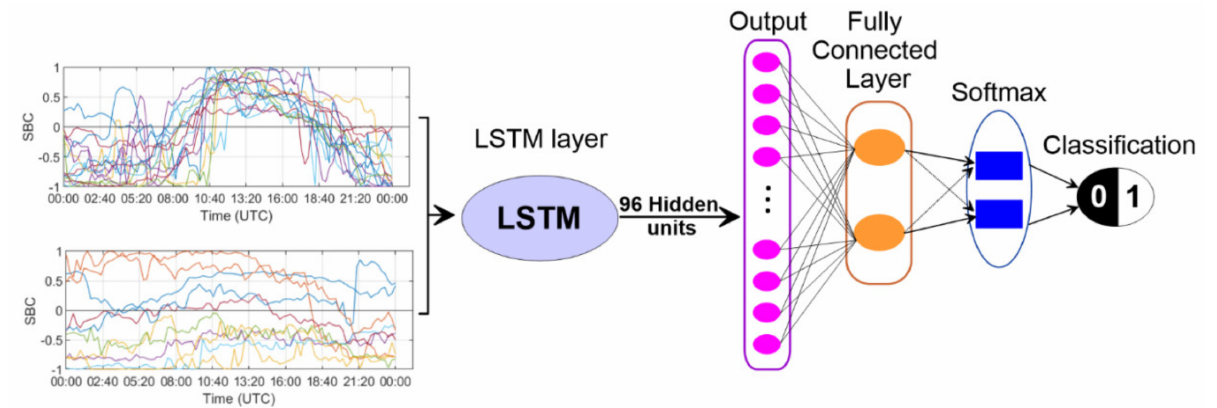
Figure 3. Machine learning recurrent neural network for the sea-breeze identification method (RNN).